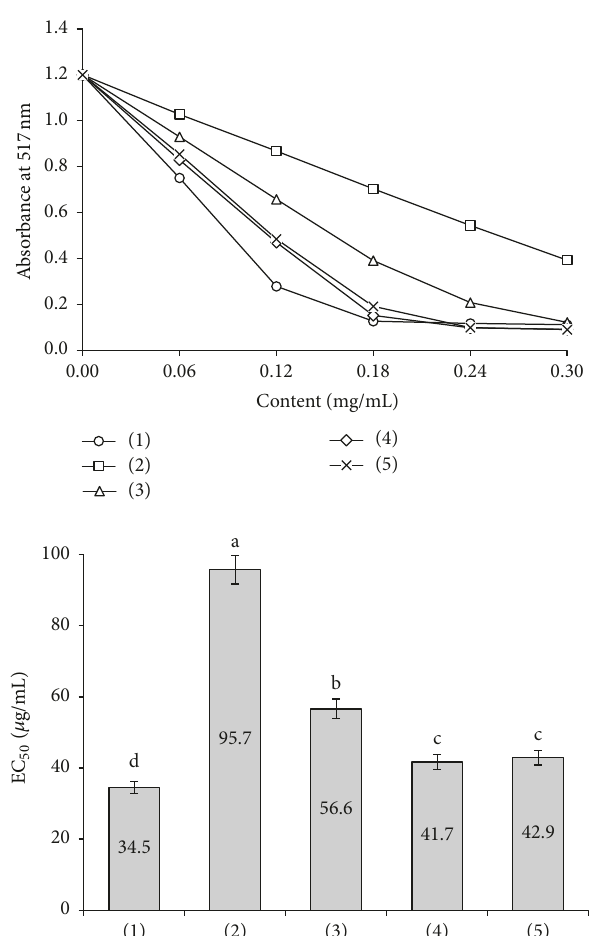
Figure 3: Antiradical activity of the extracts against the DPPH rad- ical. (1) early vegetative; (2) medium vegetative; (3) late vegetative; (4) early flowering; (5) full flowering. Means of EC 50 with different letters are significantly different ( 𝑃 < 0.05